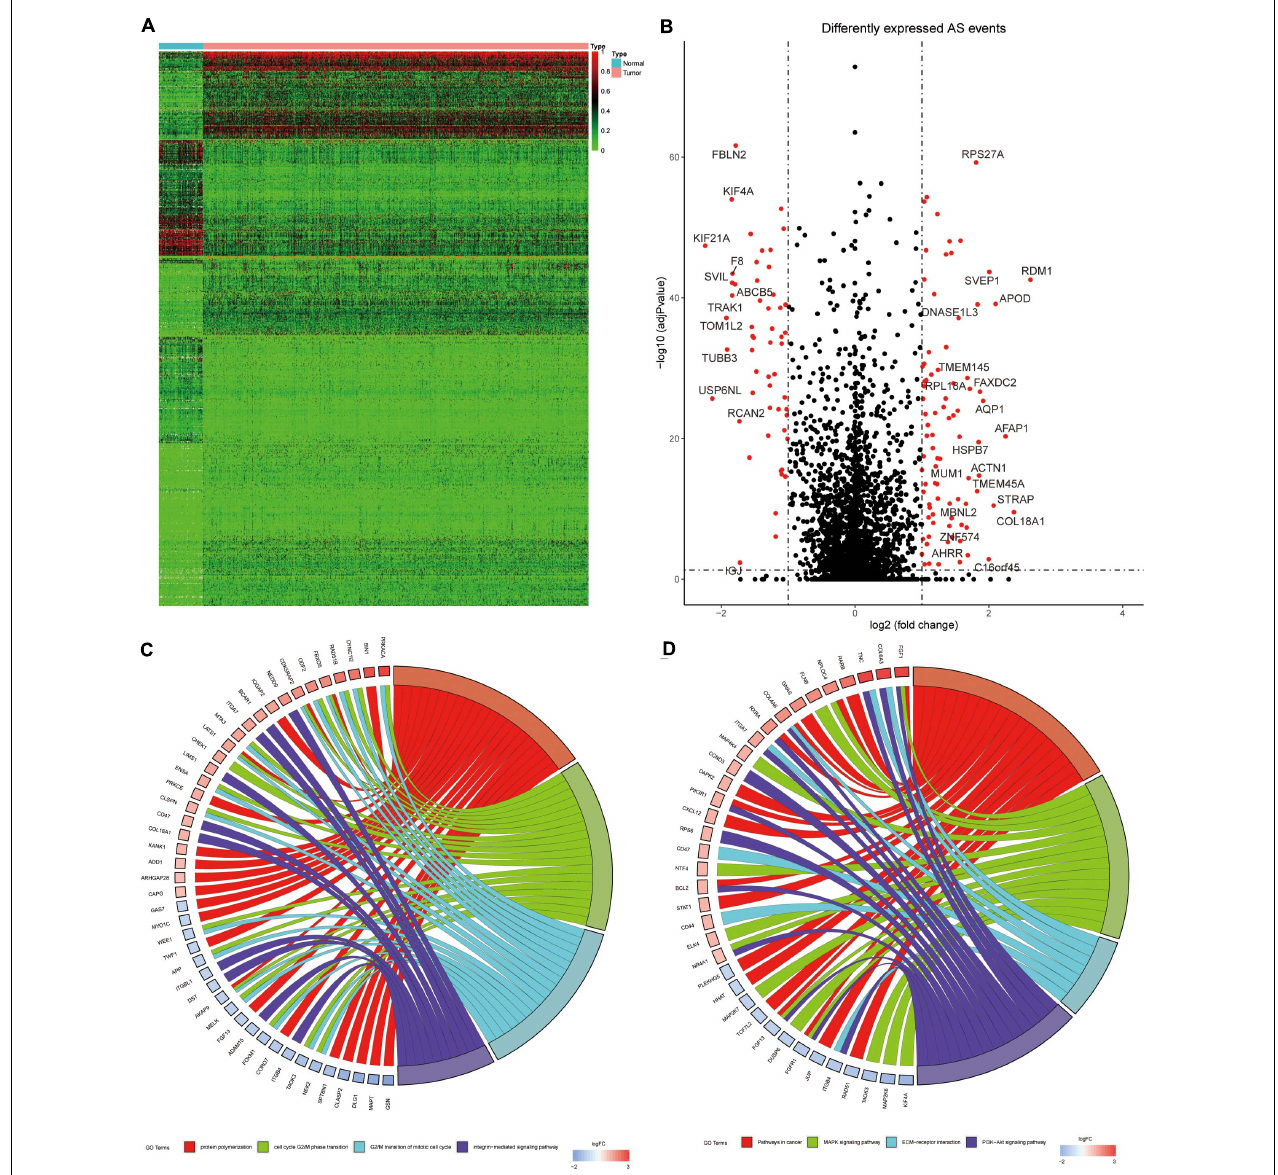
FIGURE 3 | (A) Heat map of BrCa tissues and adjacent normal tissues. (B) Volcanic diagram of BrCa 458 DEAS events, with red dots representing low-expressed or high-expressed AS events. (C) The GO 459 analysis of BrCa DEAS event parent genes. (D) the KEGG analysis of BrCa DEAS event parent genes. In (C,D) the blue to red code next to the selected gene represents logFC, and the GO term represents the biological behavior related to the parent